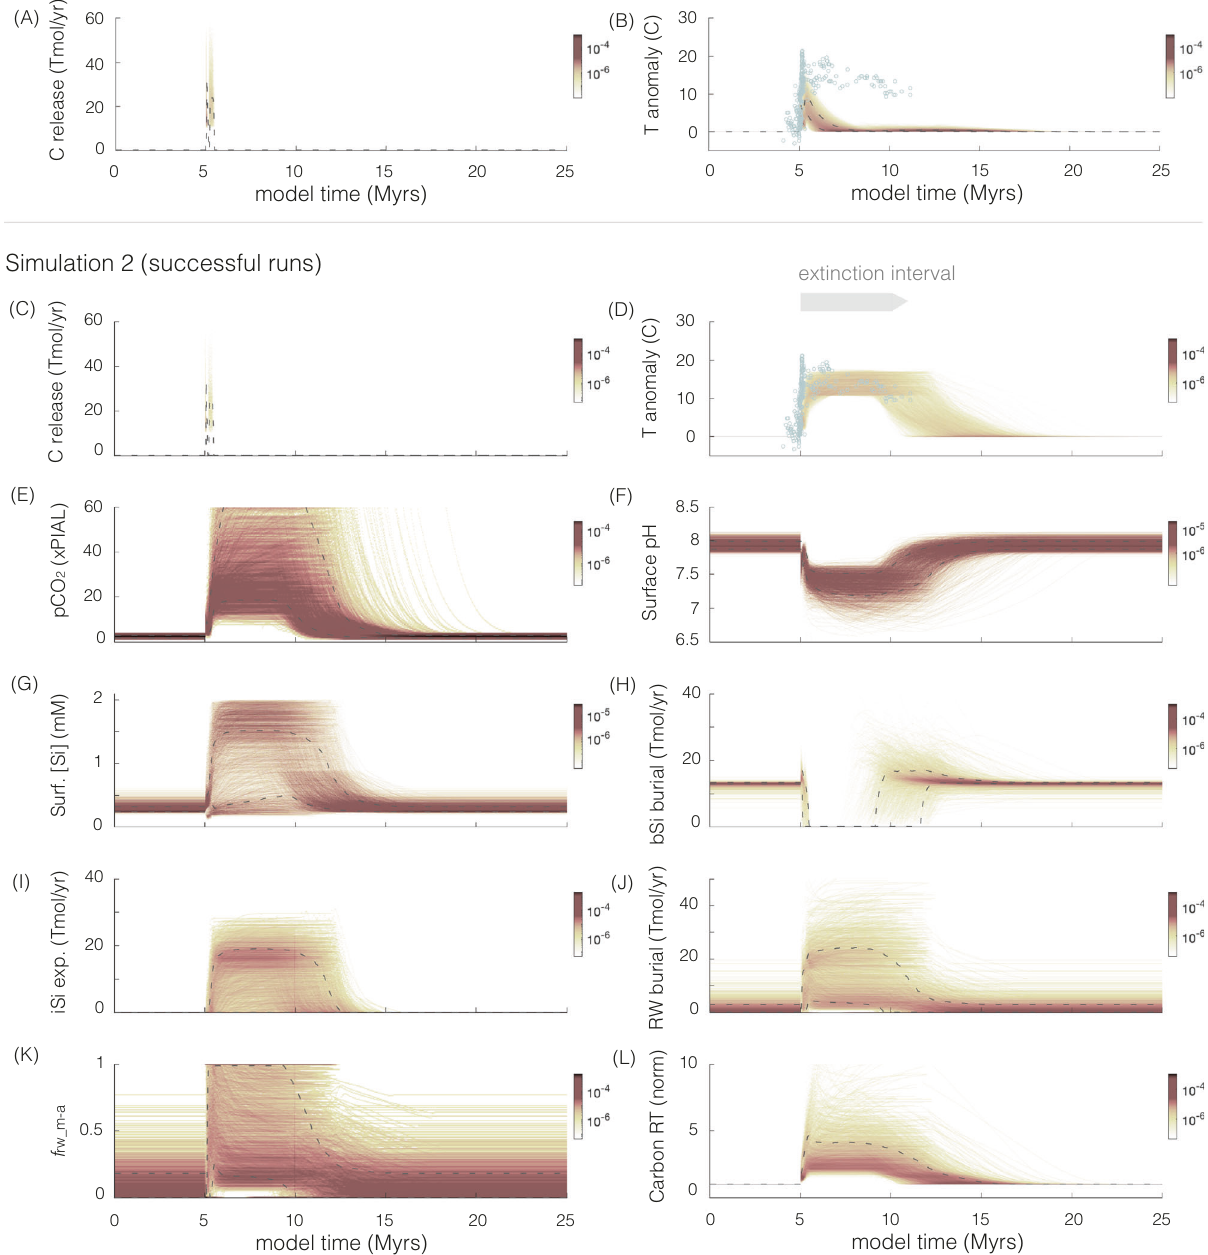
Fig. 1 Simulation 1 (degassing + fi xed carbon recycling) results ( n = 10,000) and successful model results from Simulation 2 (degassing + dynamic carbon recycling). Color bars indicate the frequency (normalized) of the results, 68% of the values are within the dashed lines. Model time of 5 Myrs marks the initiation of volcanic carbon release and the onset of extinction. Range of parameters explored: carbon release = 30,000 – 55,000Pg; release duration = 0.8 × 10 5 – 0.24× 10 6 years; and climate sensitivity = 2 – 5 °C (Supplementary Tables 2 and 3). A , C carbon released from solid earth (volcanic) and sedimentary metamorphic degassing fl uxes (Tmol/yr); B , D temperature anomaly, compared to sea surface temperature reconstructions (blue circles) 2,32,33 with age constraints based on refs. 9,87 ; E p CO 2 (times preindustrial atmospheric level (×PIAL)); F surface pH; G surface-dissolved Si